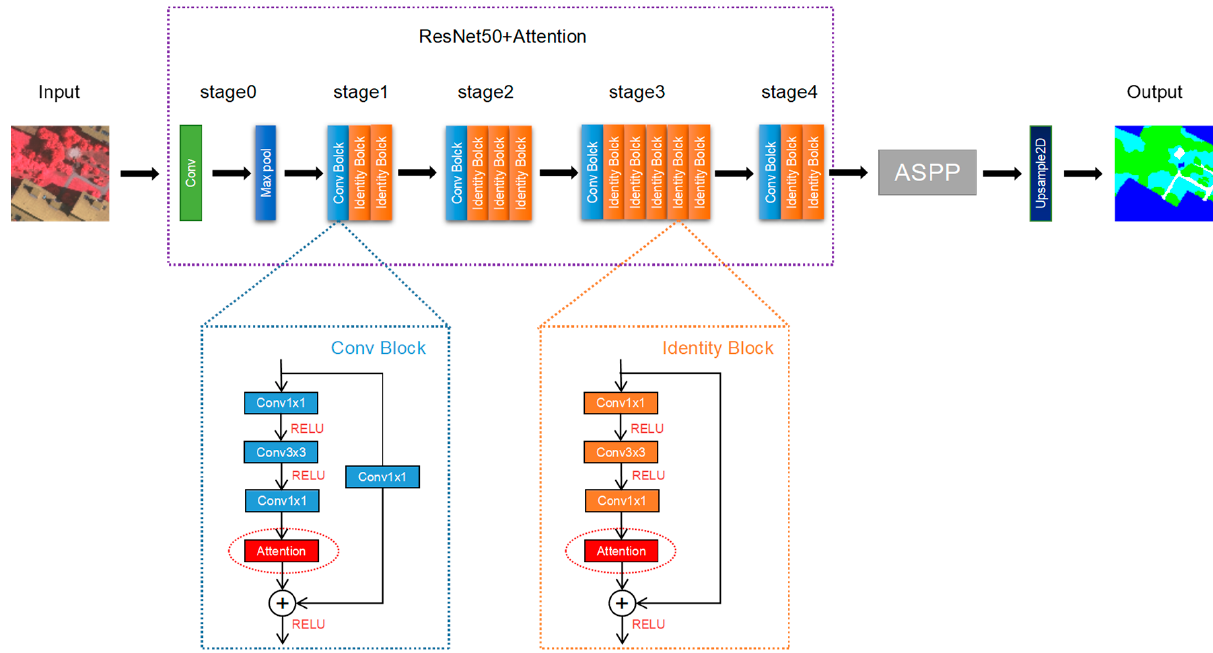
Figure 6. DeepLabV3 combined with a tt ention modules.